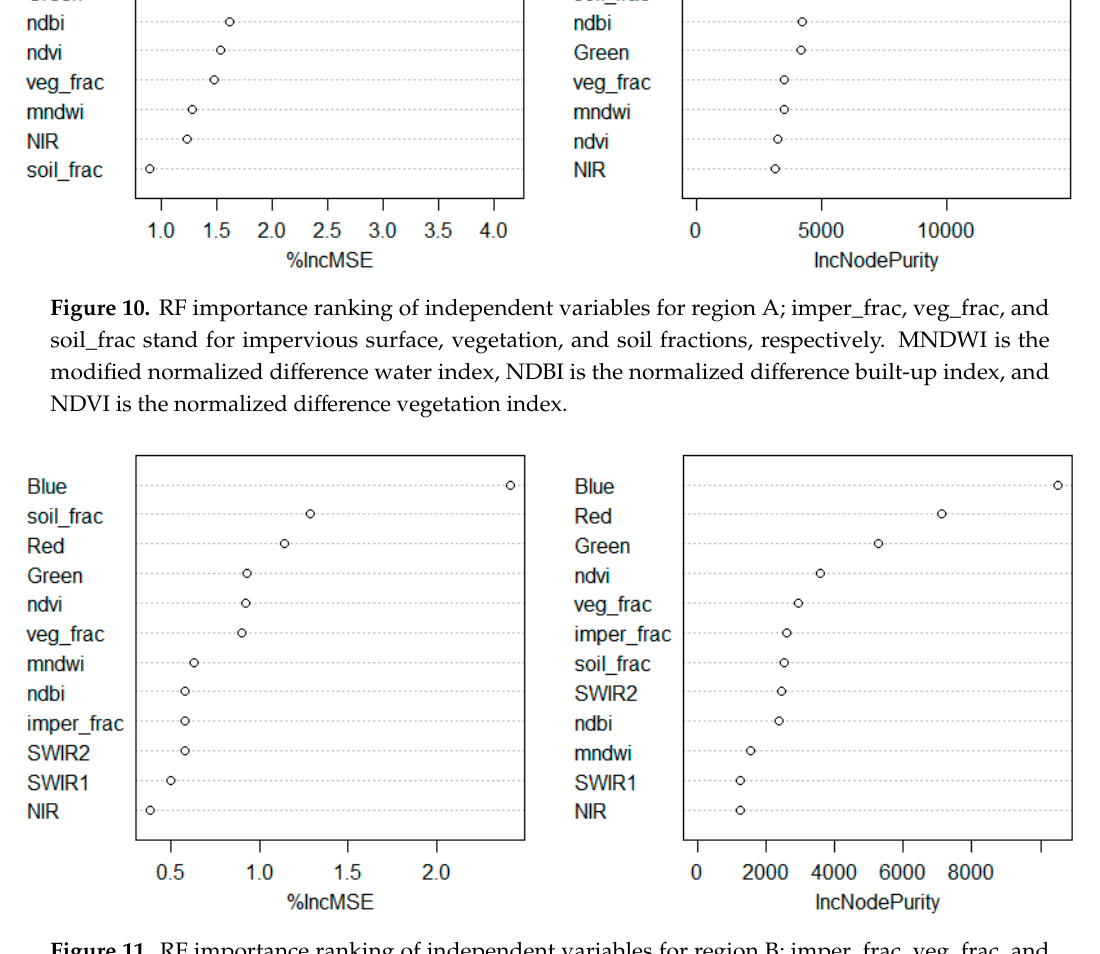
Figure 10 . RF importance ranking of independent variables for region A; imper_frac, veg_frac, and soil_frac stand for impervious surface, vegetation, and soil fractions, respectively. MNDWI is the modified normalized difference water index, NDBI is the normalized difference built-up index, and NDVI is the normalized difference vegetation index.